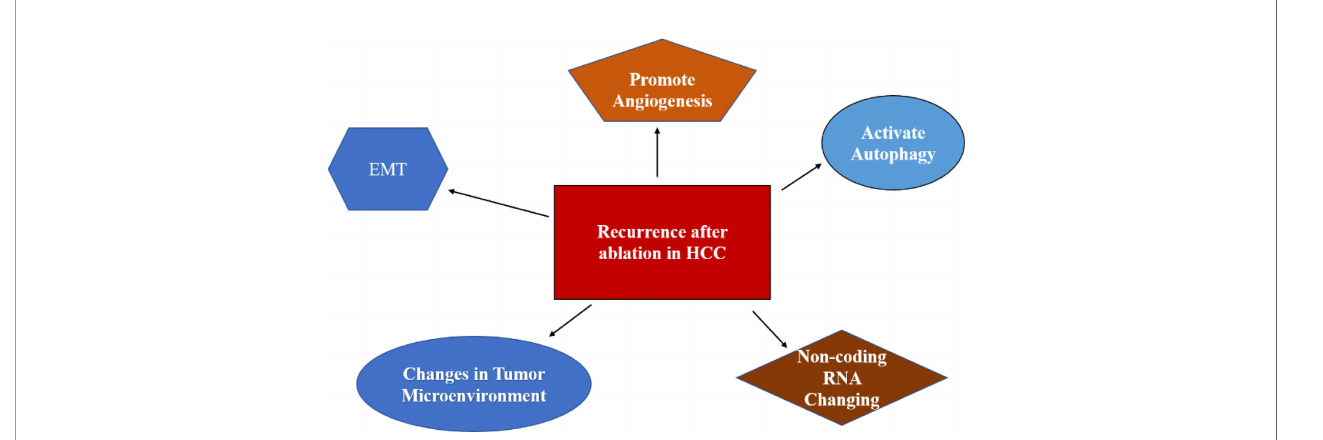
FIGURE 2 | Schematic representation of the mechanism of recurrence after ablation of HCC. .